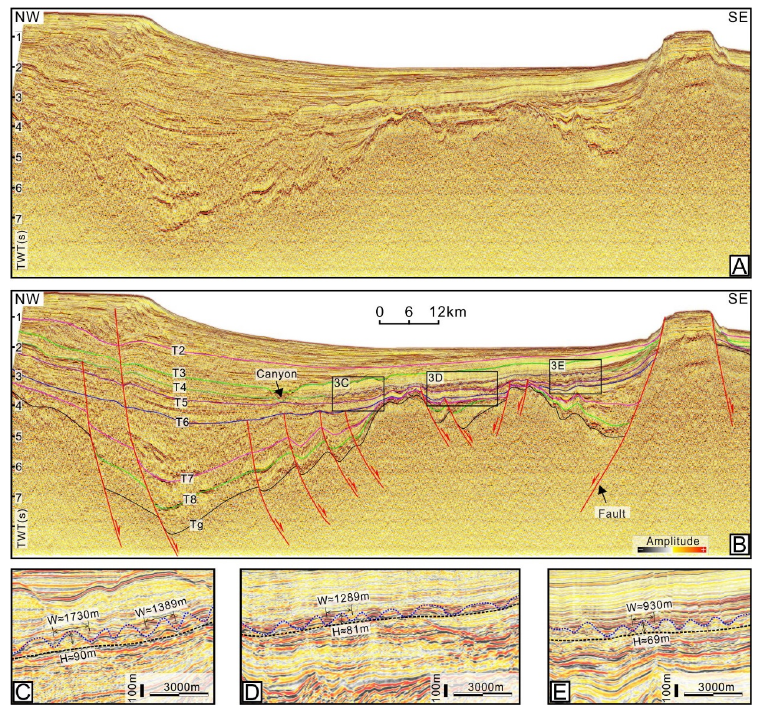
Figure 3. ( A , B ) Uninterpreted and interpreted seismic section traversing the Lingshui Sag, showing the stratigraphic and structural characteristics (for location, see Figure 1). ( C – E ) Seismic profiles and their interpretations showing the mounded topography at the top of Meishan Fm (for locations, see Figure 3A). W = width; H = height; TWT = two-way traveltime.